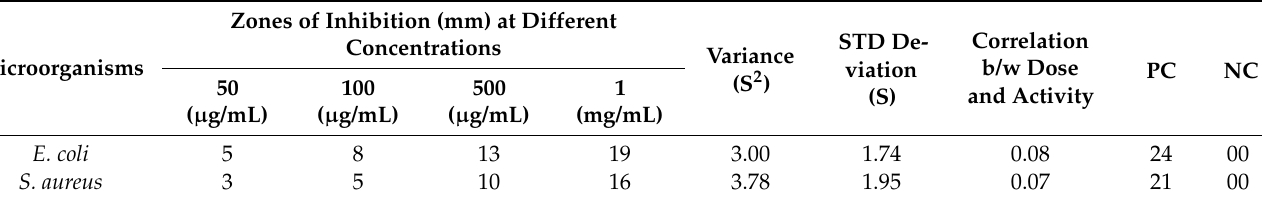
Figure 5. Pictorial representation of the antibacterial activity of B. ciliate mediated CuO NPs. Table 1. Antibacterial activity of CuO NPs against E. coli and S. aureus and zones of inhibition was measured in millimeters (mm).